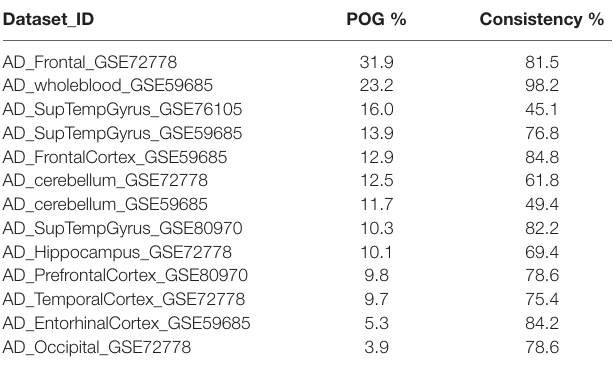
TABle 4 | Percentage of overlapping genes (POG) and